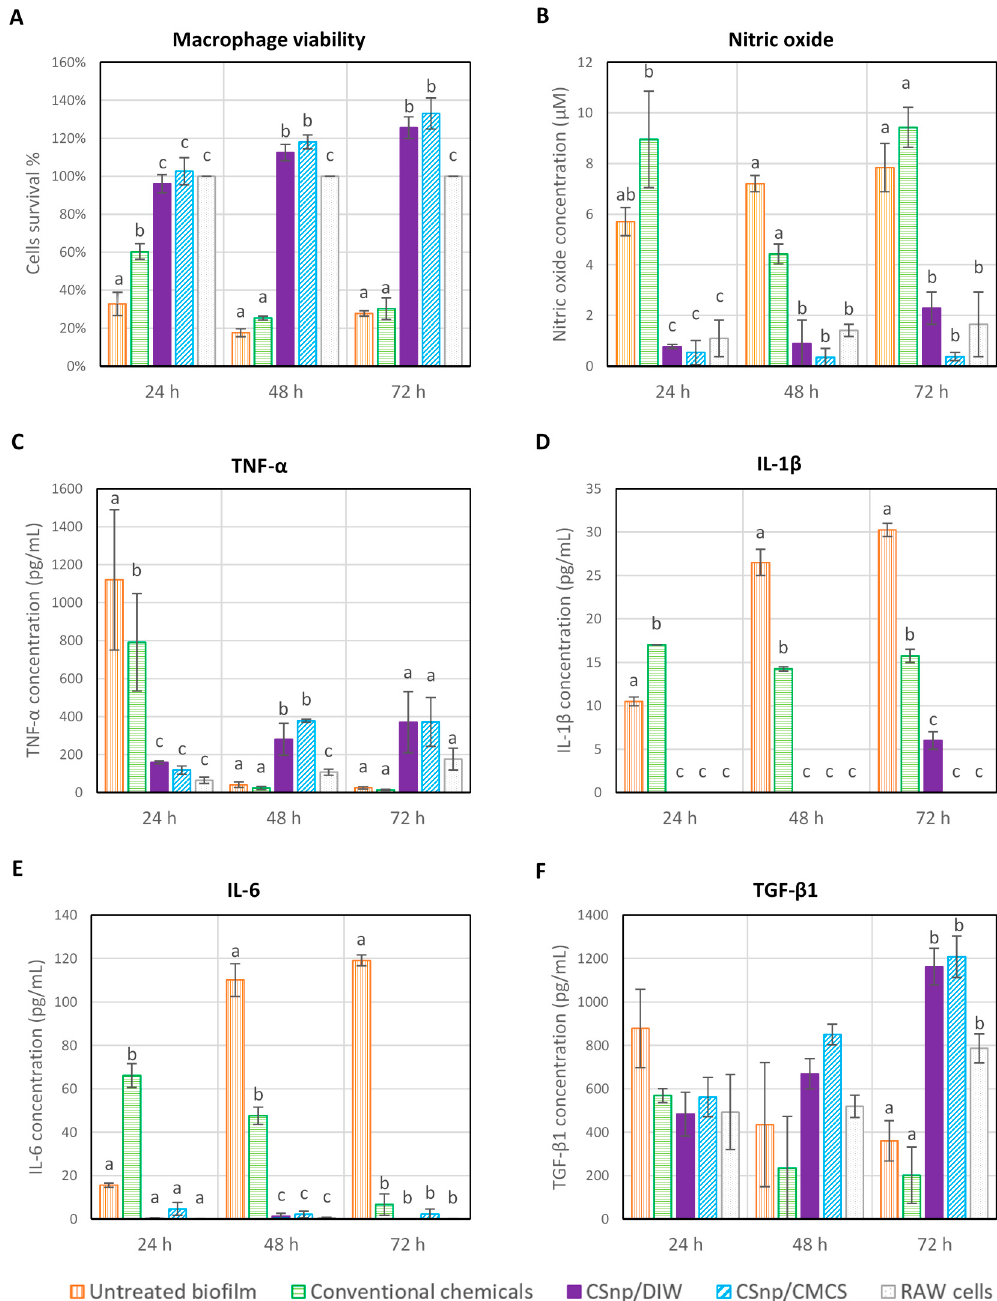
Figure 5. Macrophage survival and inflammatory markers production following interaction of treated 6-week-old E. faecalis biofilm and RAW264.7 macrophages ( A ) Relative cell viability, ( B ) Nitric oxide release, ( C ) TNF- α level ( D ) IL-1 β level, ( E ) IL-6 level and ( F ) TGF- β 1 level. Error bars represent standard error of the mean, different characters above bars indicate statistically significant difference between the groups at each time point ( p < 0.01).